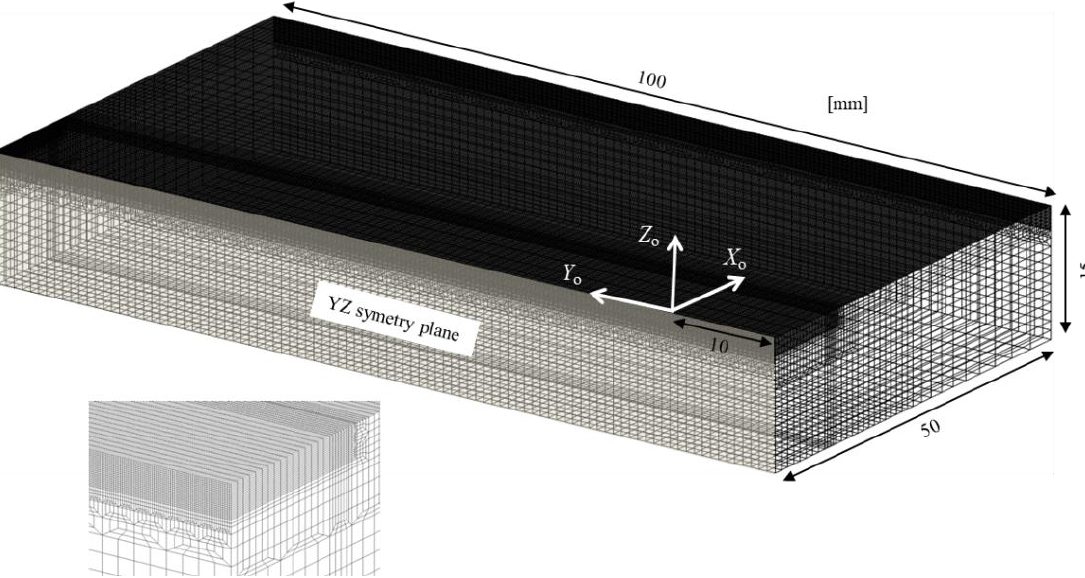
Figure 1. FE mesh of the analyzed domain.